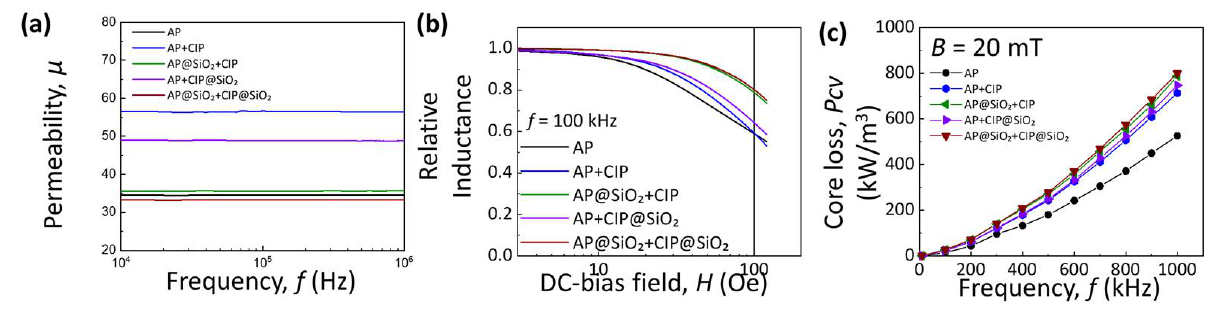
Figure 6. ( a ) Frequency-dependent permeability of insulated SMCs. ( b ) Relative inductance (%) with applied DC-bias field for insulated SMCs. ( c ) Core loss of insulated SMCs as function of frequency at B m = 20 mT. ( d ) Derived hysteresis loss constant ( K h ) and dynamic loss constant ( K dyn = K e + K a ) of insulated SMCs.